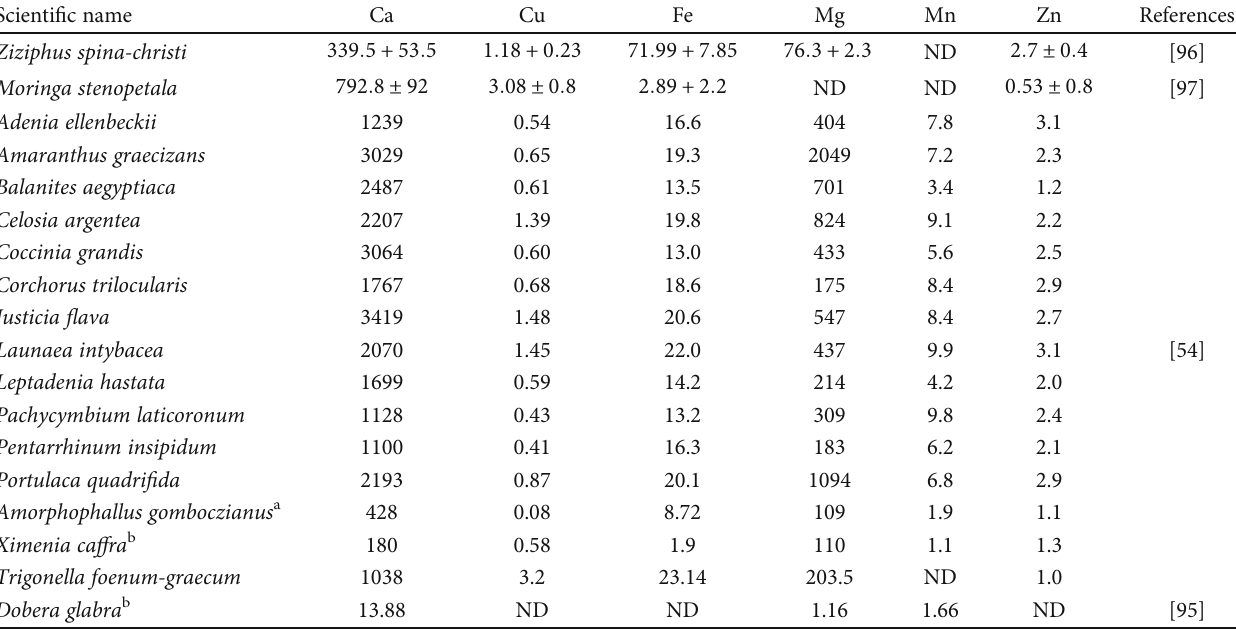
Table 2: Mineral contents (mg/100 g dry weight bases) of selected wild edible